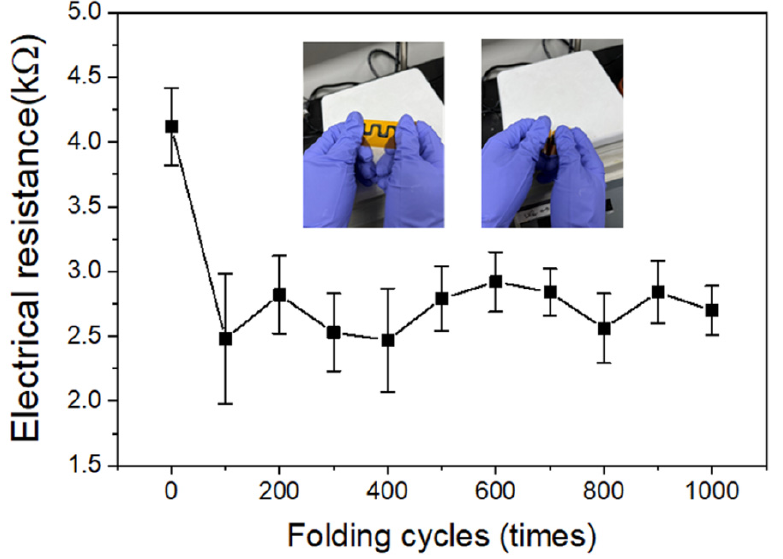
Figure 10. Changes of electrical resistance of EEG/PEDOT:PSS composite electrodes according to the folding cycles. Inset images show the folding test of the composite electrodes on the polyimide substrate. Table 2. Comparison between graphene-based inks for ink writing approaches.